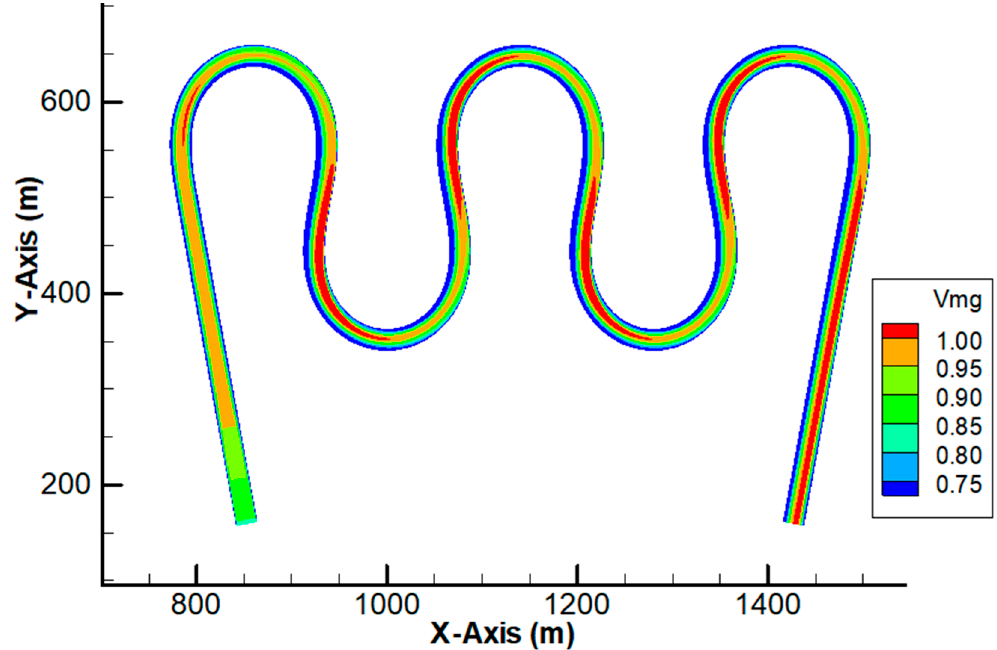
Figure 27. Simulated 3D velocity contours at the water surface for Simulation Set 5 with a sinuosity of 2.75.